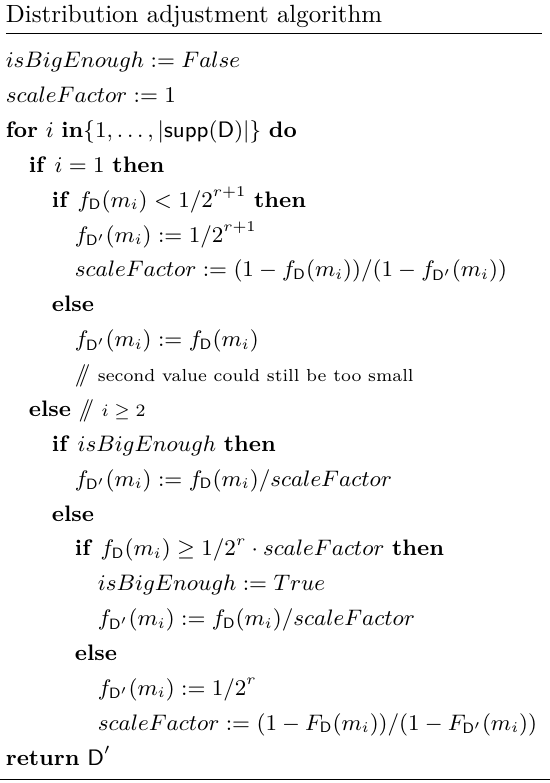
Figure 6: Distribution adjustment algorithm for distribution D and desired encoding length r , with r ≥ log | supp ( D ) | , and messages numbered by increasing frequency. 2 1 to 2 l . The messages whose frequencies are in band i , in the interval (( i − 1) · w , i · w ], will each have i homophones. In particular, the most frequent message, m homophones—all possible l -bit strings can be appended to